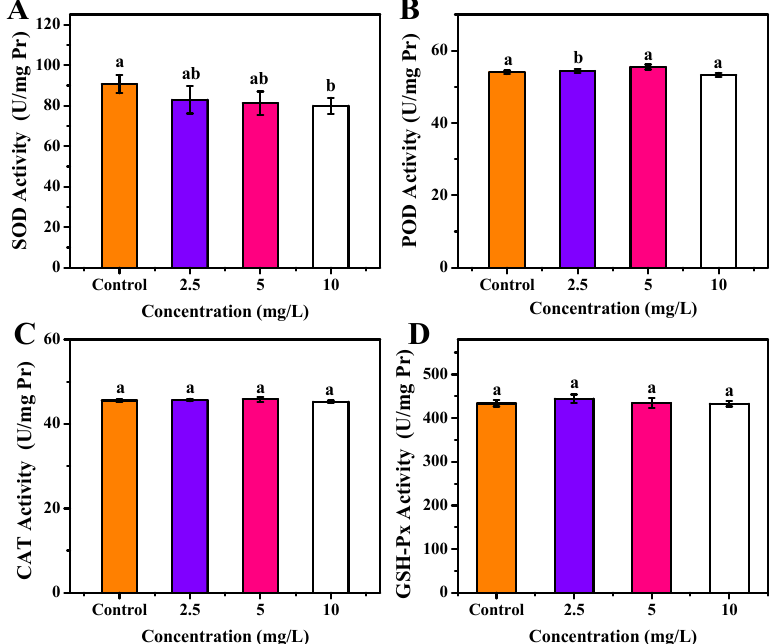
Figure 8. ( A ) SOD activity, ( B ) POD activity, ( C ) CAT activity, ( D ) GSH-Px activity of zebrafish after exposure to OCNPs in chronic toxicity test. Different letters above columns indicate significant differences ( p < 0.05 ) between treatments.